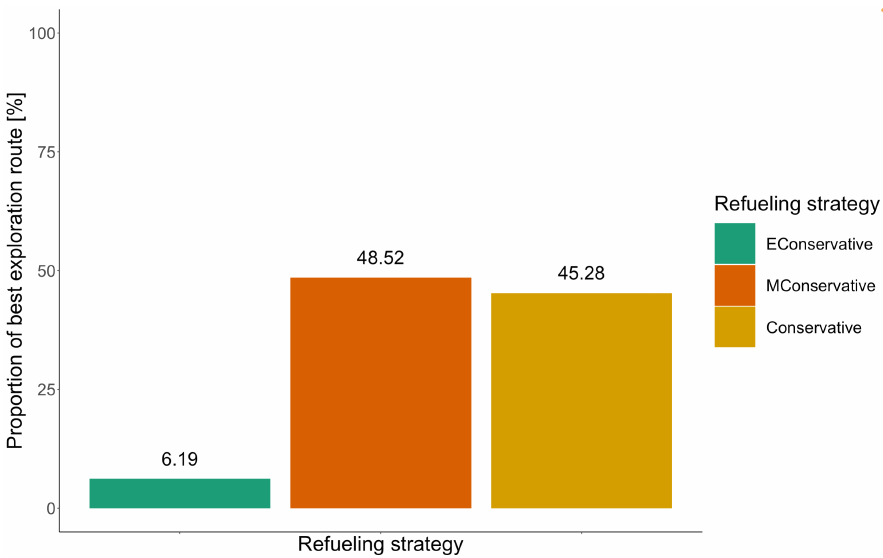
Figure 8. Global performance of refueling